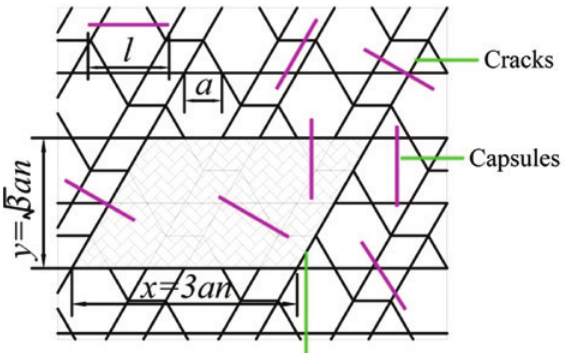
with the sizes xy